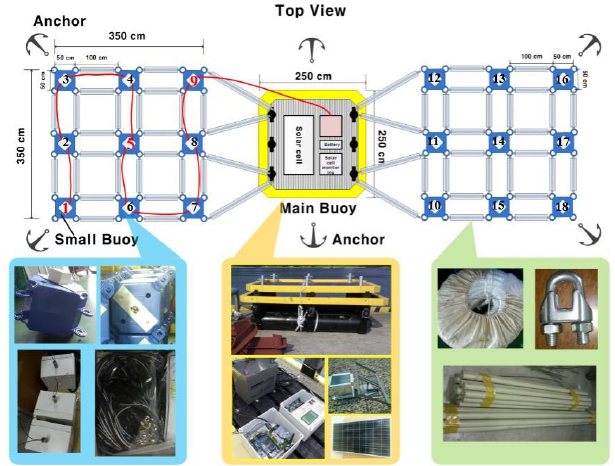
Figure 5. The IPMC system including a main buoy and modules used for the simulation and the experiment. Processes 2020 , 8 , x FOR PEER REVIEW